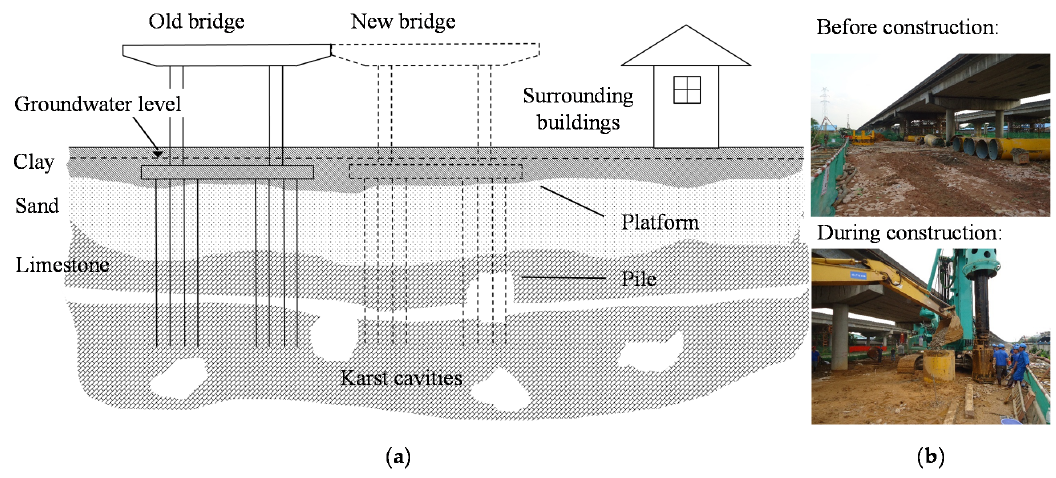
Figure 5. Schematic of the freeway extension project. ( a ) Simplified stratigraphy of the freeway extension bridge project. A new bridge will be built immediately adjacent to the old bridge; ( b ) field site before and during construction.